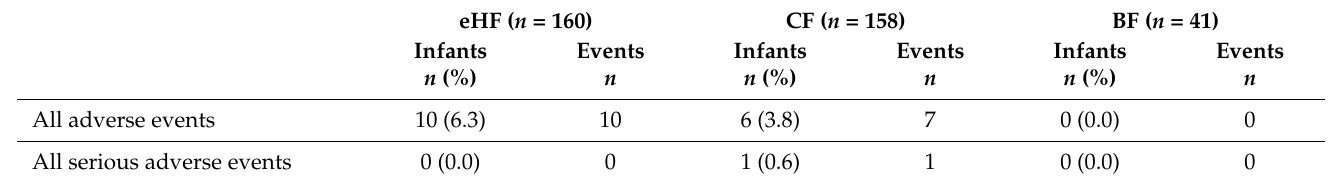
Table 5. Descriptive statistics of number of adverse events and serious adverse events between enrolment and 180 days of age (V5)